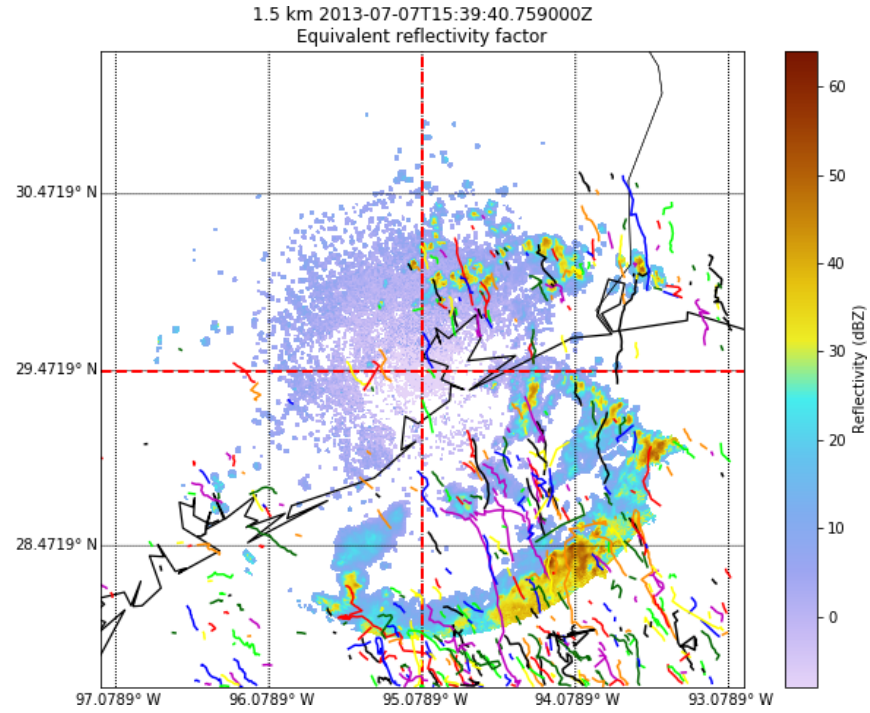
Figure 3. An example of TINT-generated cell tracks from 7 July 2013 (randomly colored lines). A constant-altitude plot of reflectivity at 1.5km is shown for reference. Each line showing the path of each cell is given a randomly generated cell identification number. The data are loaded into memory as a Pandas data frame and saved to a comma-separated variable file for later